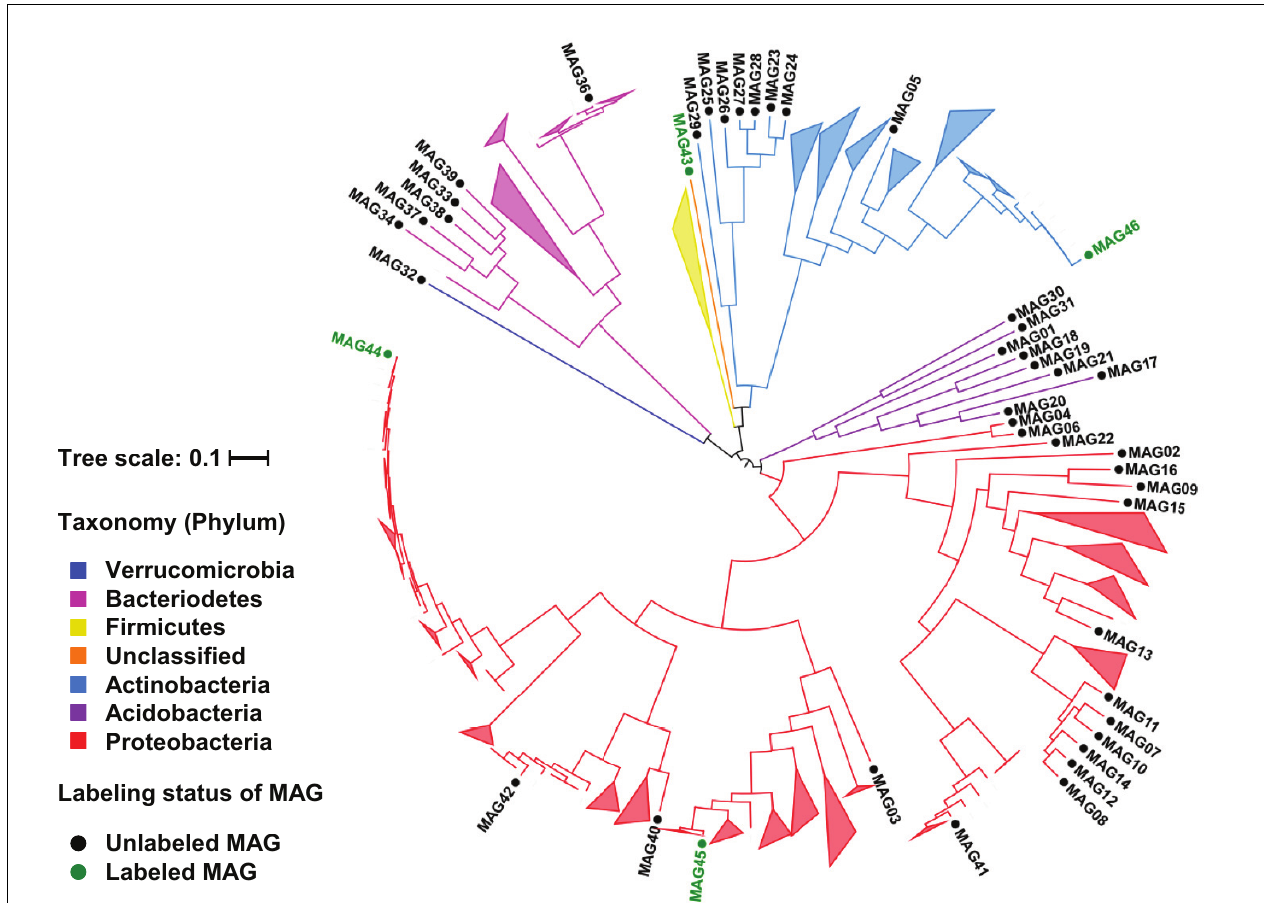
FIGURE 1 | Phylogenomic tree of MAGs in the phylogenomics context of existing root-associated bacterial isolate genomes. Branches labeled with MAG IDs represent the 41 unlabeled and 4 labeled bacterial MAGs recovered from this study. The MAG35 from the Archaea was not shown on the tree. The remaining branches and all collapsed clades represent the 523 existing isolate genomes from Levy et al. (2018). Branches are color-coded based on the phylum-level taxonomy. MAGs for the 13 C-labeled microorganisms in 13 CO 2 rhizosphere proteomic SIP are shown in green.